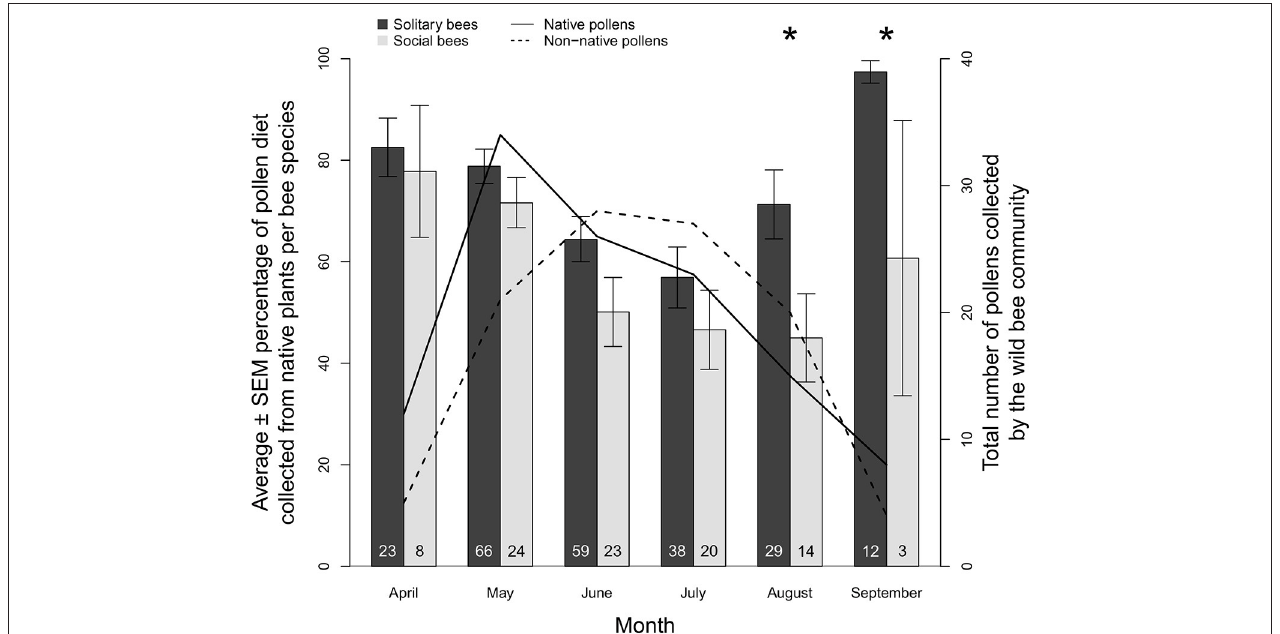
FIGURE 2 | Average ± SEM proportion of pollen collected from native plant genera by wild solitary bee species ( n = 152, black bars) and wild social bee species ( n = 29, gray bars) from April to September in Michigan (2006–2018). The number of bee species for each month is indicated at the base of each bar. Asterisks indicate a significant difference in average native pollen consumption between wild solitary and social species ( p < 0.05). The total number of native plant pollens collected by the whole wild bee community is shown by the solid black line, and the number of non-native pollens is shown by the dashed line.